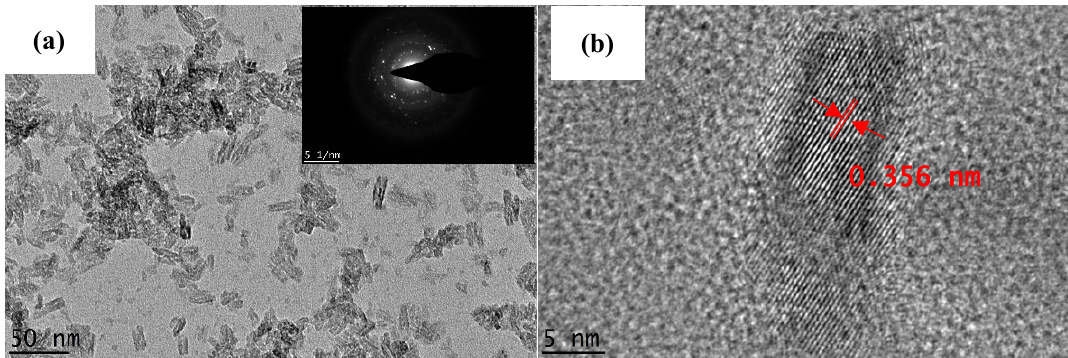
Figure 3. ( a ) TEM images of the synthesized TiO 2 nanoparticles at a magnification of 88 kX and ( b ) high-resolution TEM image of the synthesized TiO 2 nanoparticles at magnification of 620 kX. Figure 4a,b show the FESEM images and the distribution curve of the synthesized SiO 2 core prepared through the Stober method using 20% water in an absolute ethanol solution, 0.3 M of TEOS and 0.55 M of NH 4 OH. The image clearly shows that the synthesized SiO 2 core is in the form of a highly dispersed well-rounded sphere with a mean size of about 255.0 nm and a standard deviation of 20.69 nm. Figure 4c,d show the FESEM images of the SiO 2 coated with TiO 2 nanoshell taken at two different magnifications of 50 kX and 200 kX. The FESEM images confirm that TiO 2 were successfully coated on the surface of the SiO 2 sphere. The high magnification FESEM image (Figure 4d) reveals that the TiO 2 are in the form of nanoparticles with a size below 10 nm covering the surface of the SiO 2 , resulting in the rough surface morphology of the sphere. The electron energy loss spectroscopy (EELS) mapping analysis was utilized to reveal the distinct division between the SiO 2 core and the TiO 2 shell. Figure 4e is an image of the EELS analysis of a single SiO 2 -TiO 2 core-shell sphere structure. In the image, the diameter of SiO 2 is about 320 nm (denoted in red), while the shell thickness of TiO 2 is about 10–20 nm (denoted in blue). The result was supported by the scanning HRTEM/energy-dispersion X-ray (STEM-EDX) line scan analysis, as shown in Figure 4f. In the graph of the atomic distribution of the EDX line scan, the broad red line represents the SiO 2 core, and the Ti line width (blue line) represents the thickness of the TiO 2